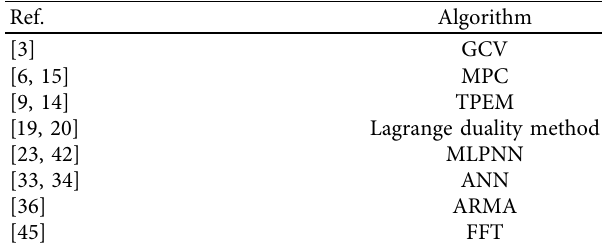
Table 6: Algorithms for forecasting.